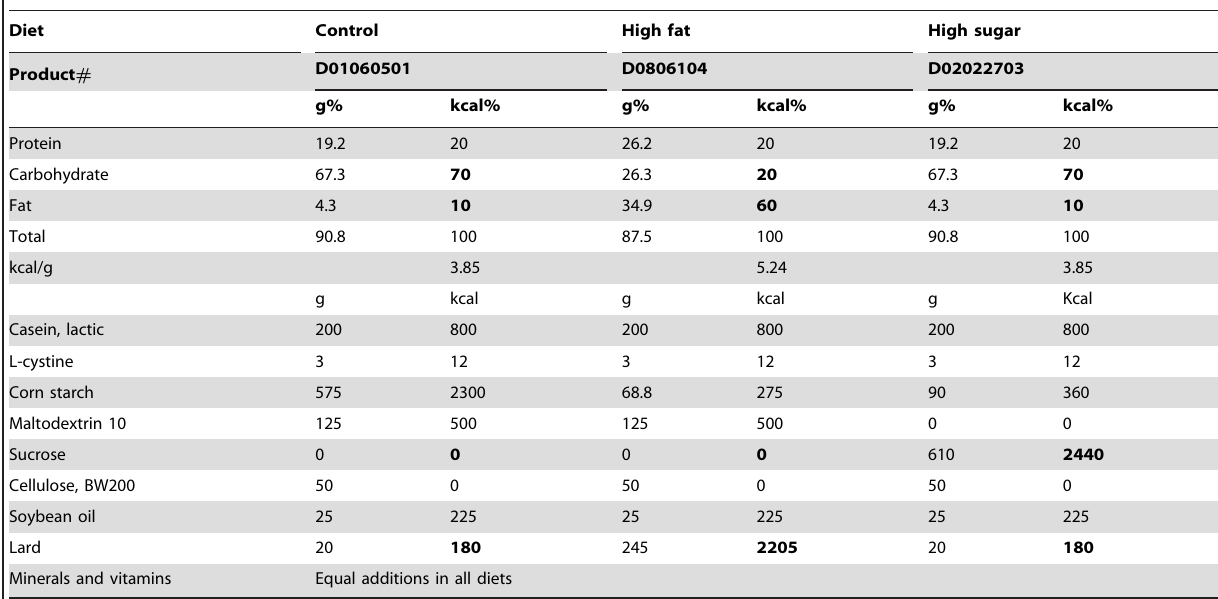
Table 1. The experimental